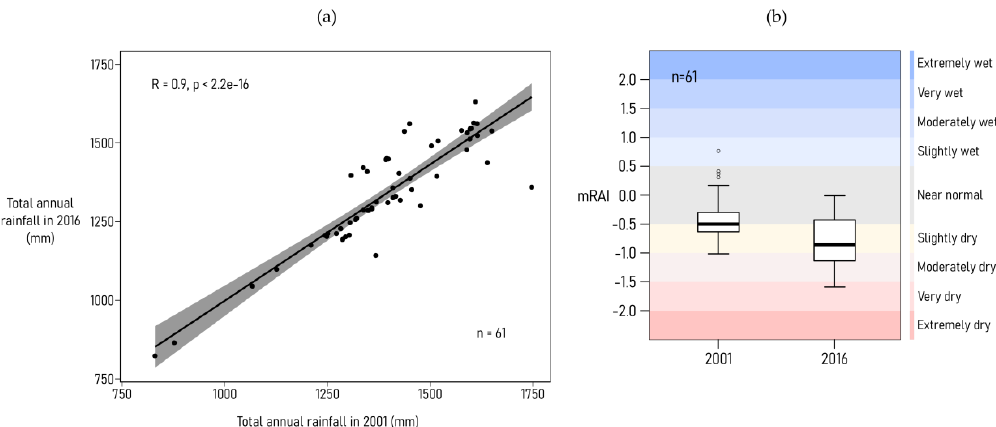
Figure A1. ( a ) Scatter plot showing significant positive linear correlation between the total annual